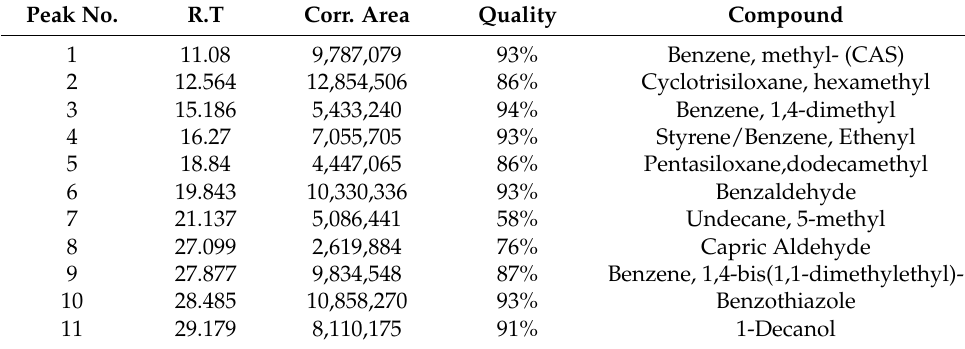
Table 3. Volatile organic compounds (VOCs) detected from samples of B. bassiana . Peak No.